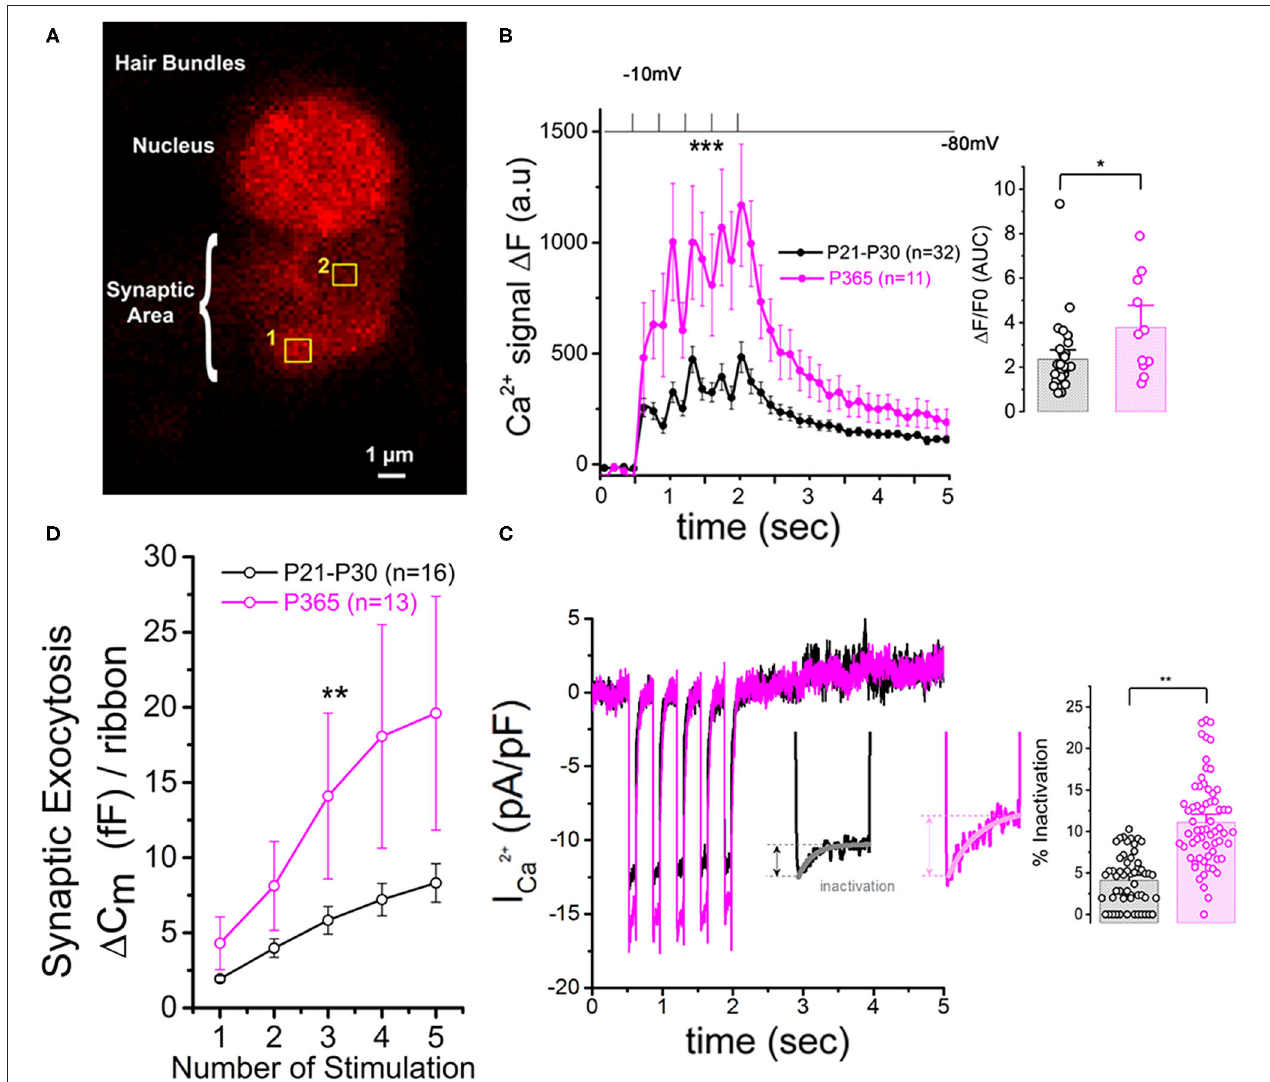
FIGURE 8 | Larger synaptic Ca 2 + signaling and increased sustained exocytosis in aged IHCs. (A) Example of confocal Ca 2 + imaging, using the intracellular fluorescent Ca 2 + indicator Rhod2, in an IHC. The cell was voltage-clamped at − 80mV and stimulated by 5 (100ms) consecutive voltage-step to − 10mV. The photograph shows two examples of square zones (1 µ m 2 ) below the cell nucleus where voltage-induced calcium increase was measured. (B) Comparative mean amplitude of transient fluorescent hot spots showed higher Ca 2 + responses at the presynaptic active zones of old P365 IHCs (pink) as compared to young mature P30 IHCs (black).